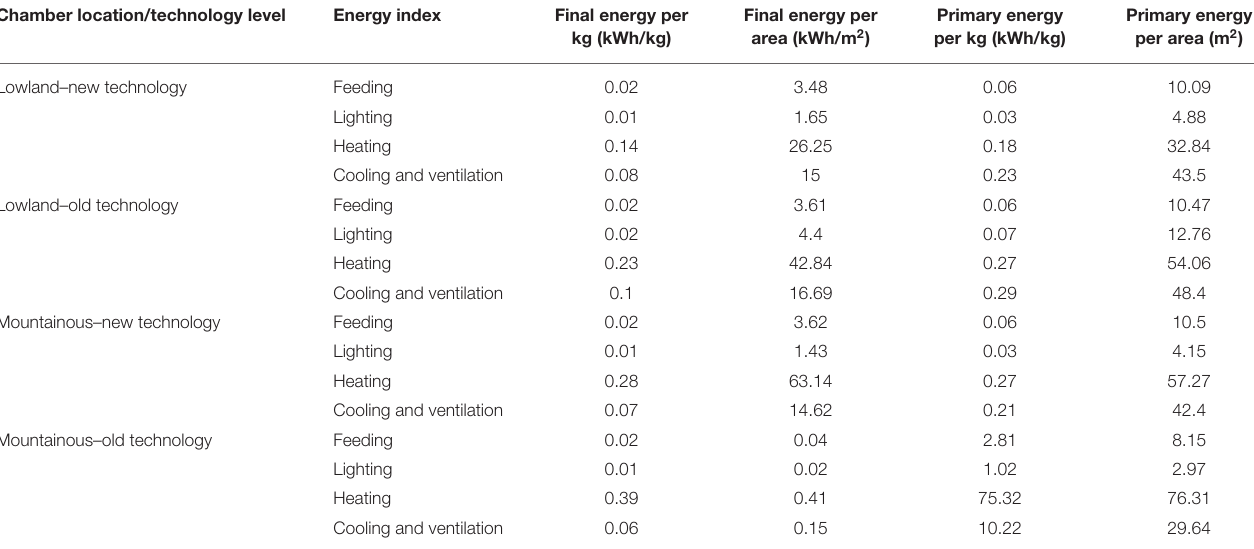
TABLE 6 | Energy indices according to the energy usage of the examined broiler facilities. Chamber location/technology